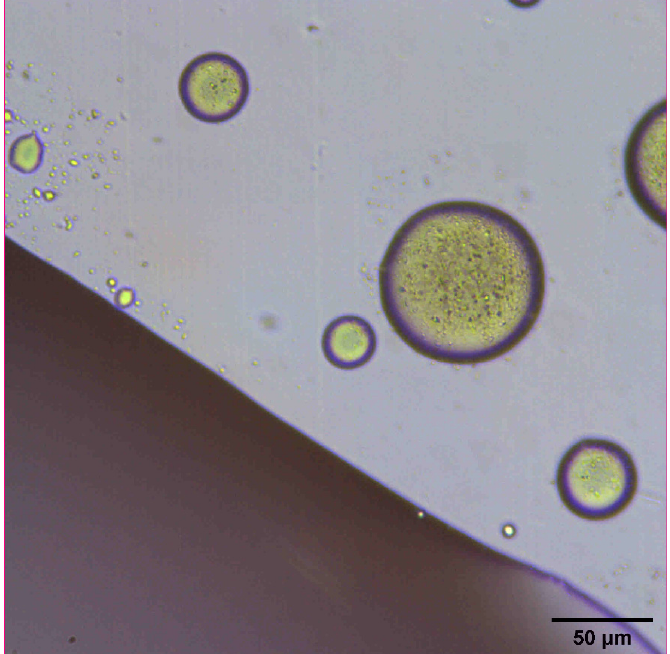
Figure 6. Optical microscope image of 10 mg/mL concentration naproxen nanosuspension after inkjet printing onto a film transparency. A drop of water was added to observe the redispersion and reconstitution of the dried nanosuspension droplets.